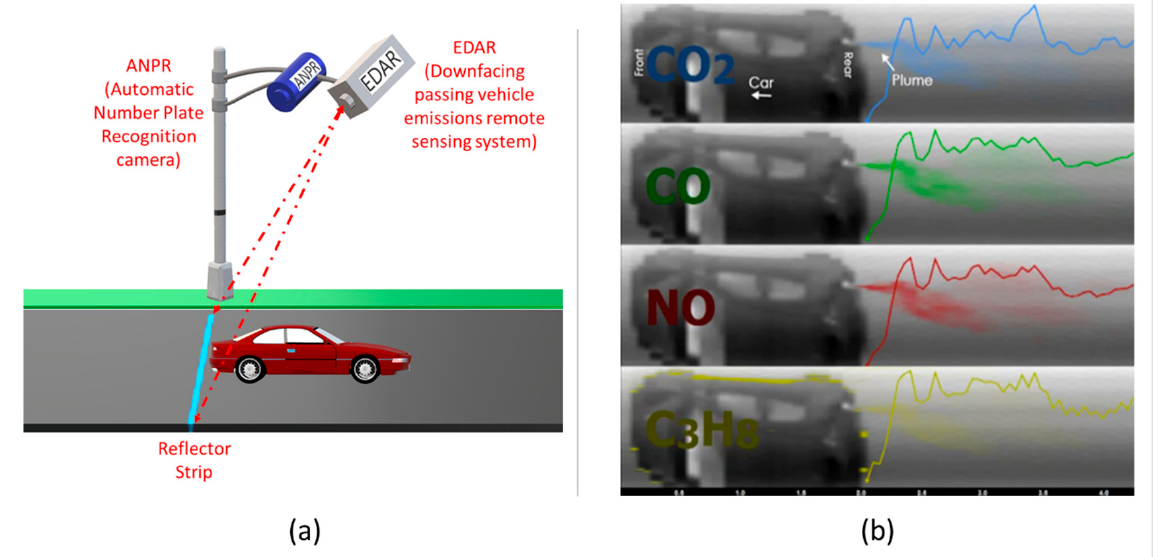
Figure 3. A schematic diagram of how EDAR is deployed on roads. ( a ) The alignment of the EDAR device to the road, ( b ) the information received by the EDAR device.